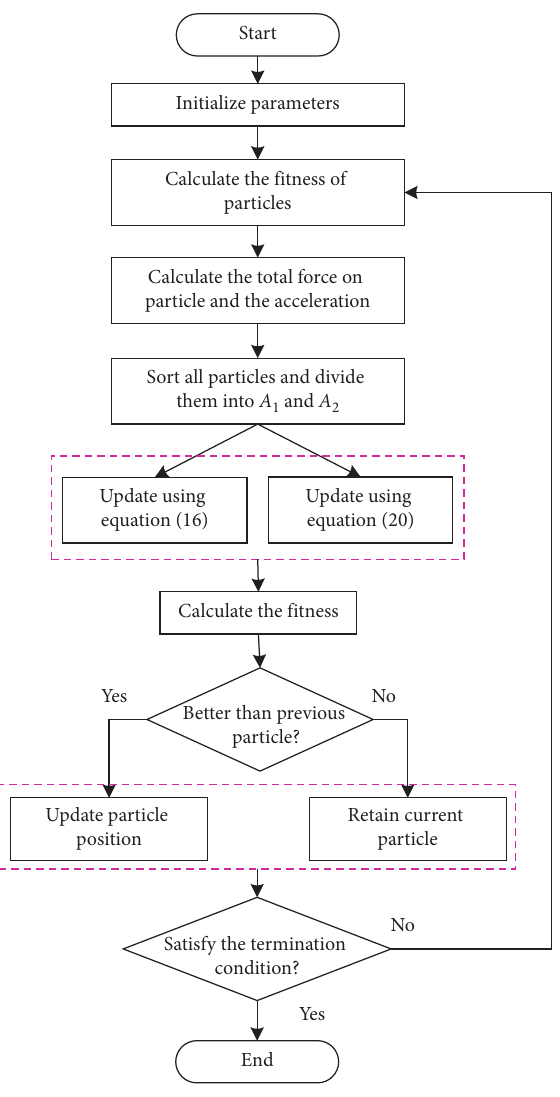
Figure 2: Flowchart of